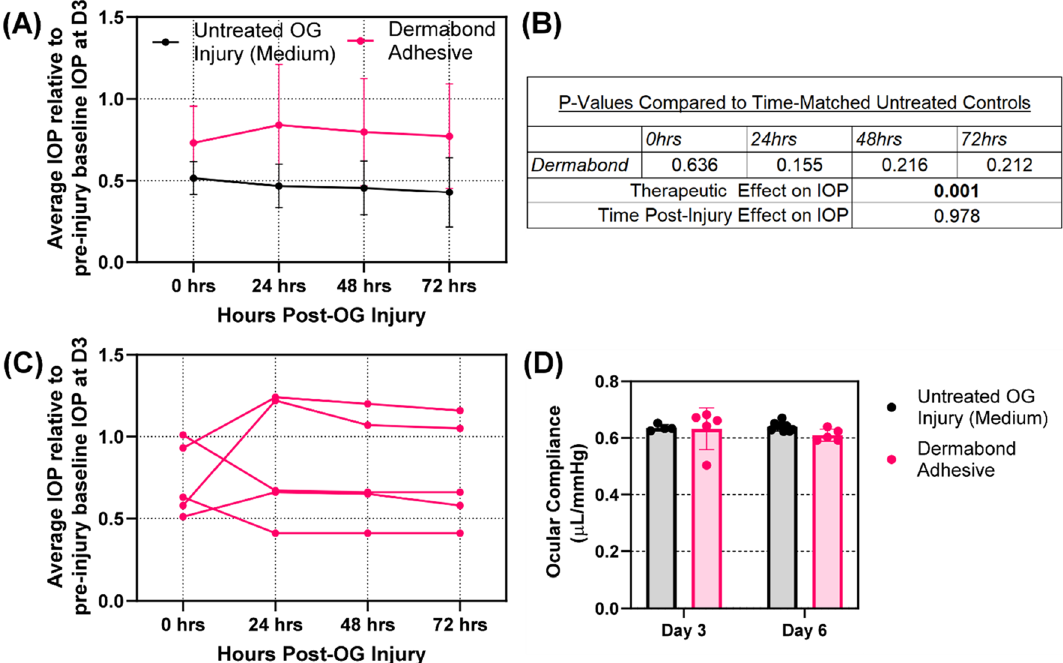
Figure 8. Effect of Dermabond tissue sealant on maintaining IOP and Ocular compliance. ( A ) Average IOP relative to baseline levels immediately after injury and 24, 48, and 72 h post injury for untreated and Dermabond treated tissue. ( B ) Summary of p values for Dermabond vs. untreated time-matched controls, as well as the effect of therapeutic and time on IOP, as determined by two-way ANOVA, post-hoc Šídák method. Values are bolded when statistically significant ( p < 0.05) ( C ) Each of 5 Dermabond treated replicate responses across the 72 h following injury and treatment to highlight the variability between the replicates. ( D ) Ocular compliance for untreated and Dermabond treated tissue immediately post injury (D3 organ culture) and 72 h post injury (D6 organ culture). Results are shown as mean and error bars denote standard deviation throughout.